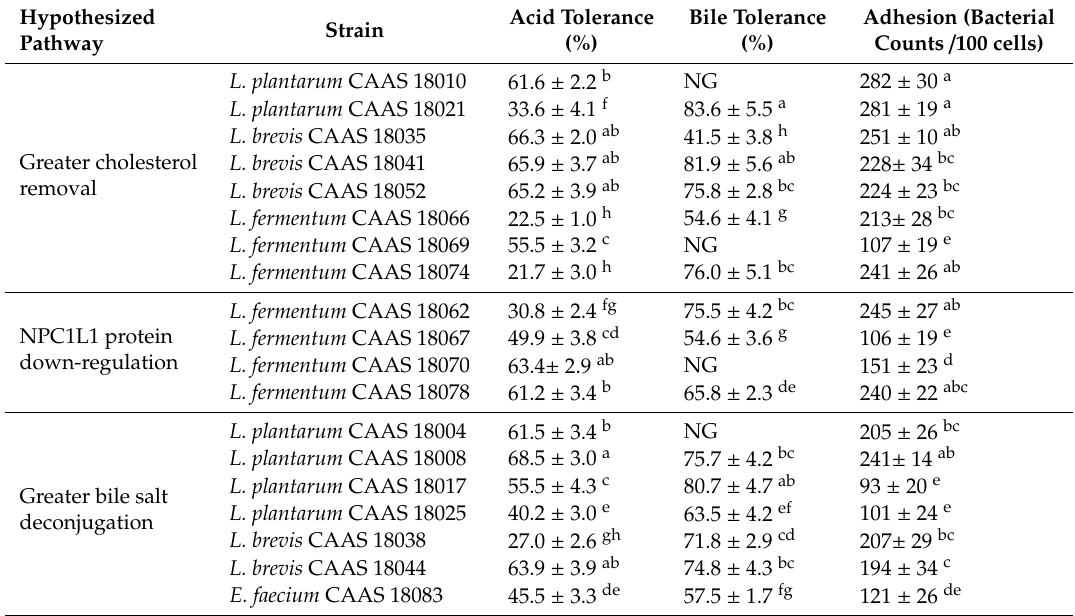
Table 1. Acid tolerance, bile tolerance, and adhesion ability of the selected